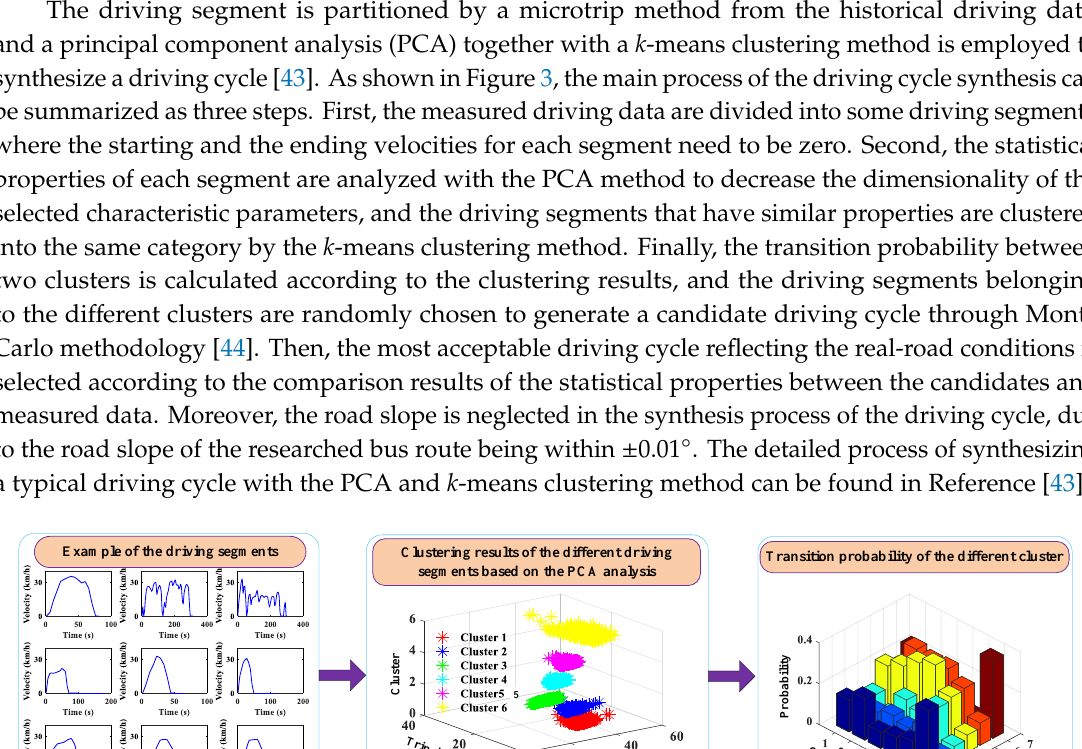
Figure 2. Measurement of the historical driving data.